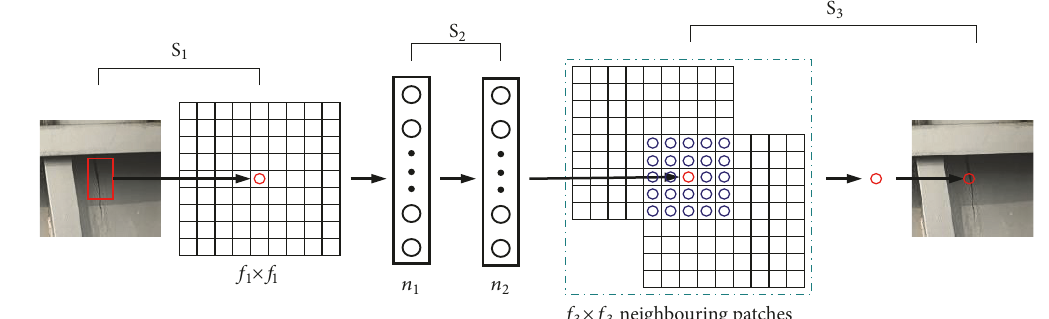
Figure 3: Illustration of sparse coding combined neural network SR reconstruction [21].